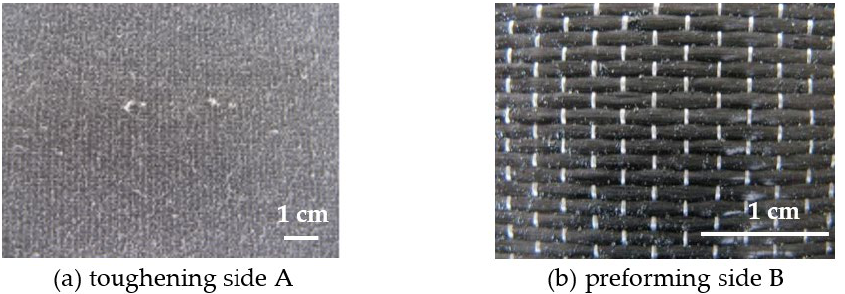
Figure 6. Images of the bifunctional CF fabric surface with toughening agents ( a ) and preforming agents ( b ).